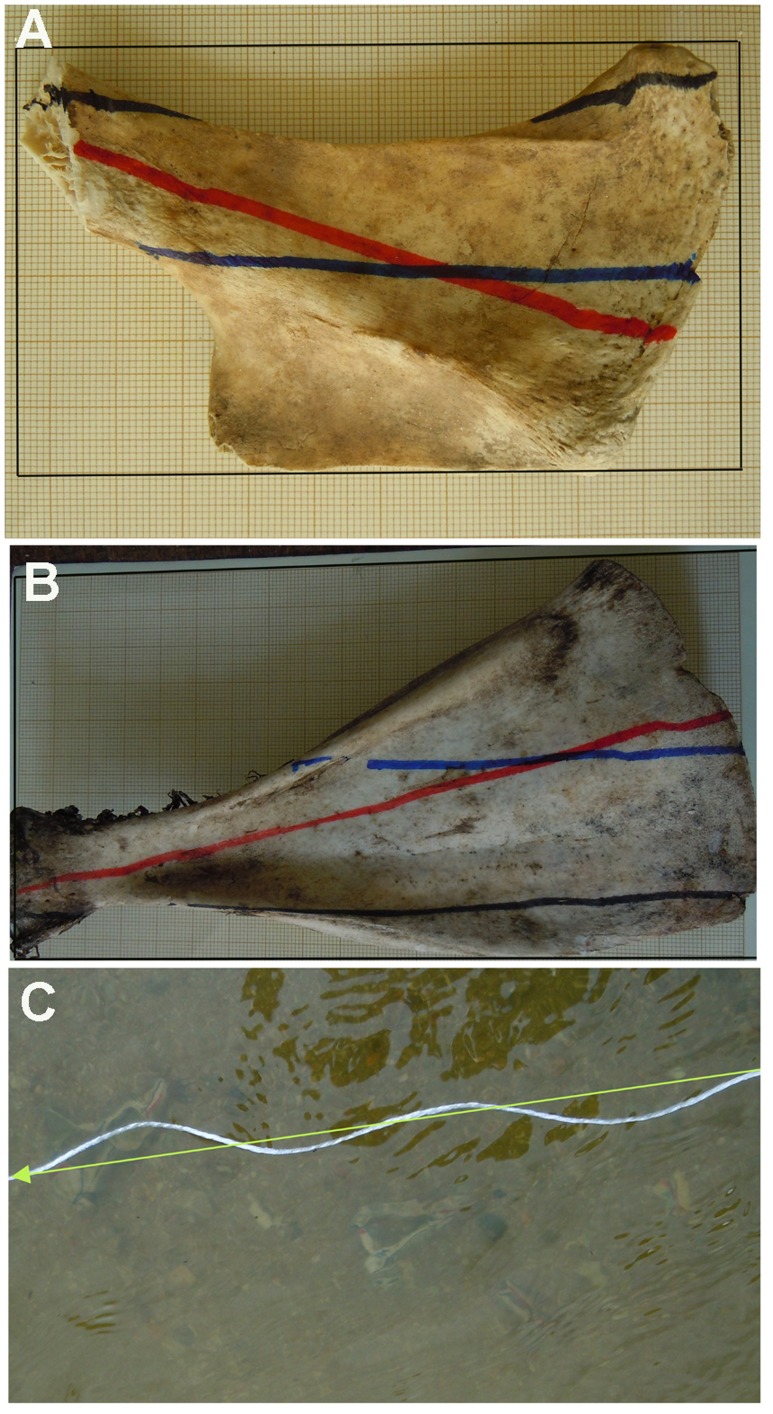
Orientation patterns of bones with different shapes.A and B, examples of SLA (red), DPA (black) and MBRA (blue) in irregular shaped bones. C, fluvial experiment with bones oriented and water current direction indicated by arrow and string.